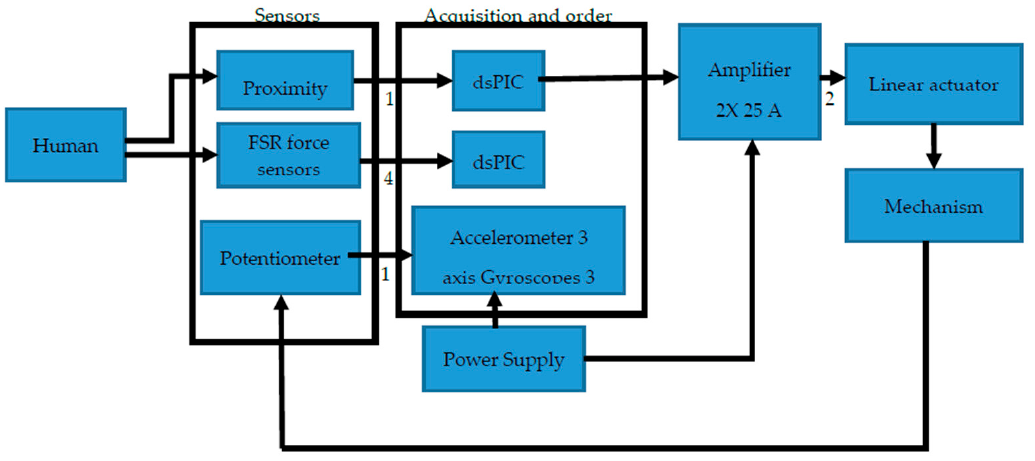
Figure 4. Electronic connection diagram.